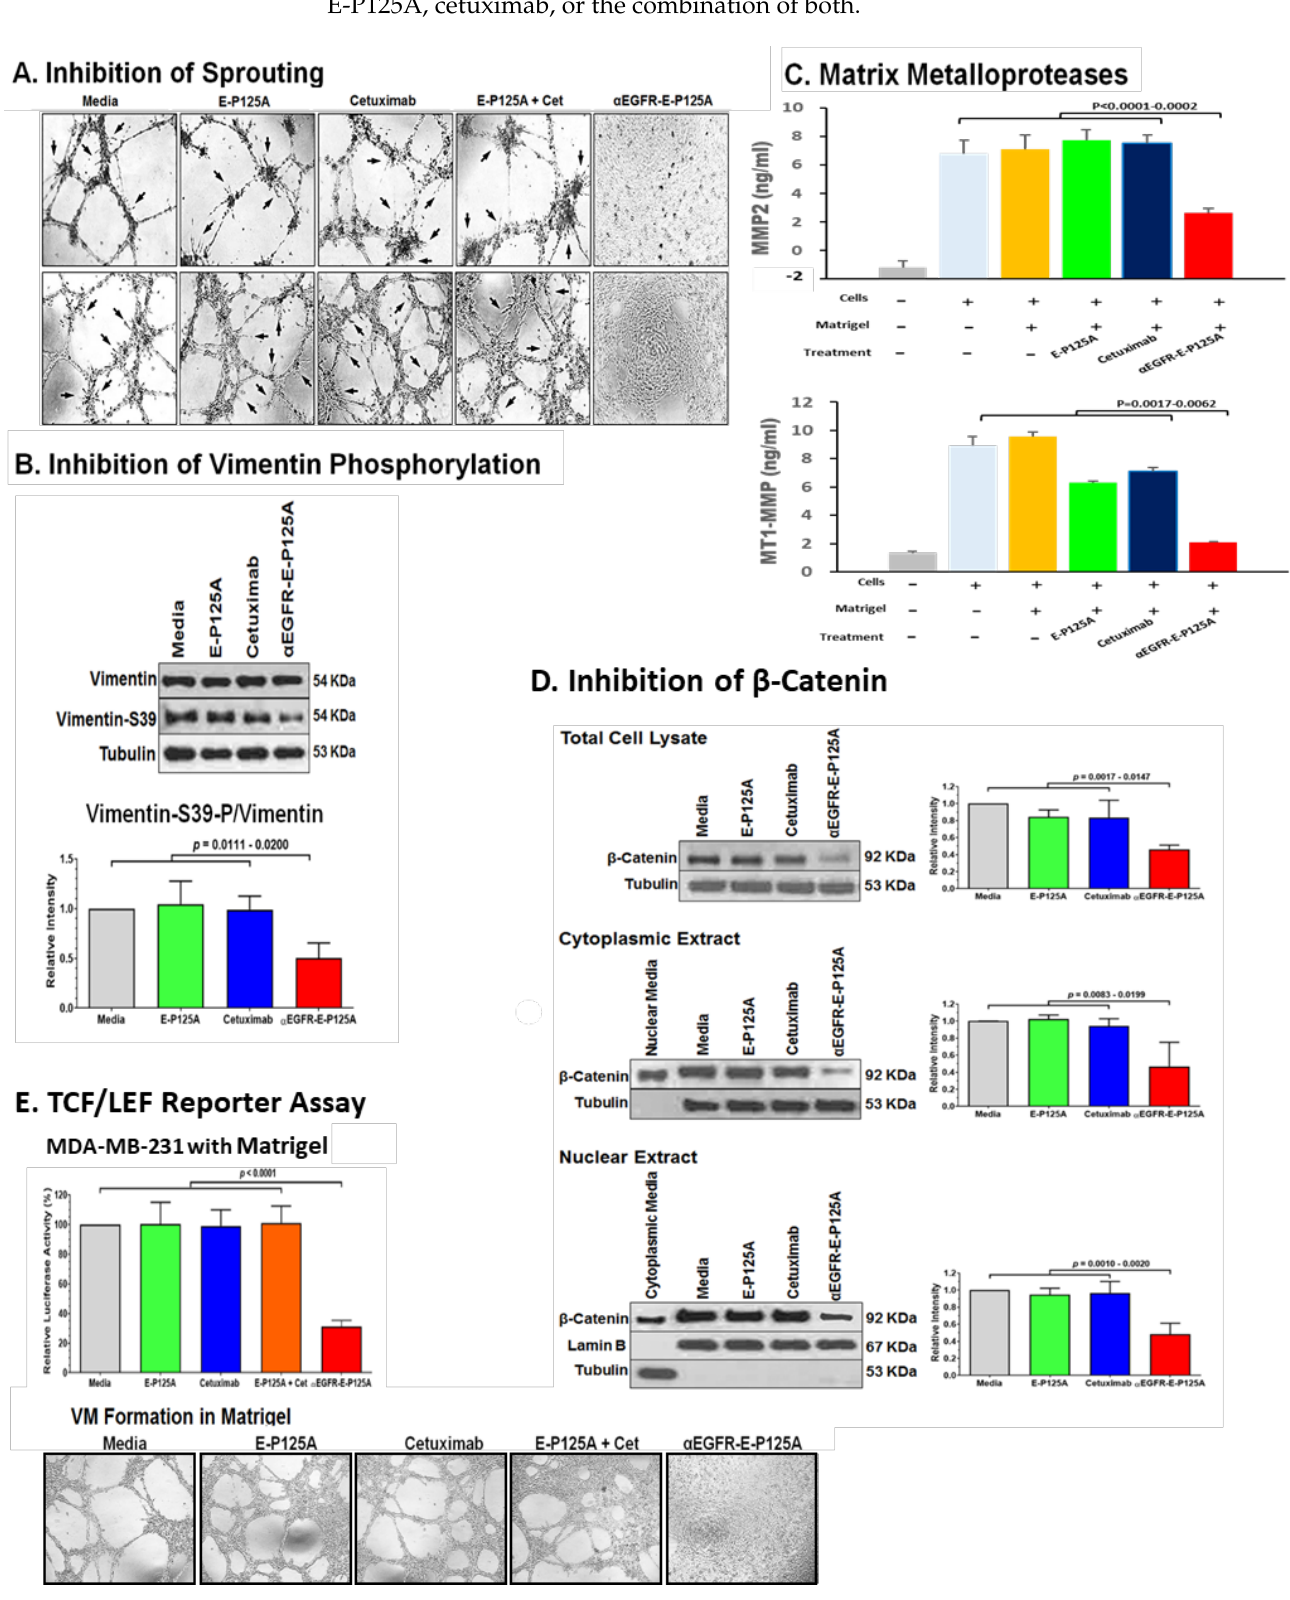
Figure 3. ( A ) Effects of αEGFR-E-P125A on sprouting: Tube formation by HUVECs or MDA-MB-231-4175 plated on matrigel, untreated or treated with E-P125A (58 μg/mL), cetuximab (170 μg/mL, Cet), a combination of E-P125A (58 μg/mL) and cetuximab (170 μg/mL), or αEGFR-E-P125A (250 μg/mL) for 16 h. Sprouting indicated by black arrows. ( B ) Western blot analysis for vimentin and SER39-phosphorylated vimentin following αEGFR-E-P125A treatment: MDA-MB-231-4175 cells plated in matrigel were treated with E-P125A (58 μg/mL), cetuximab (170 μg/mL), or αEGFR-E-P125A (250 μg/mL)